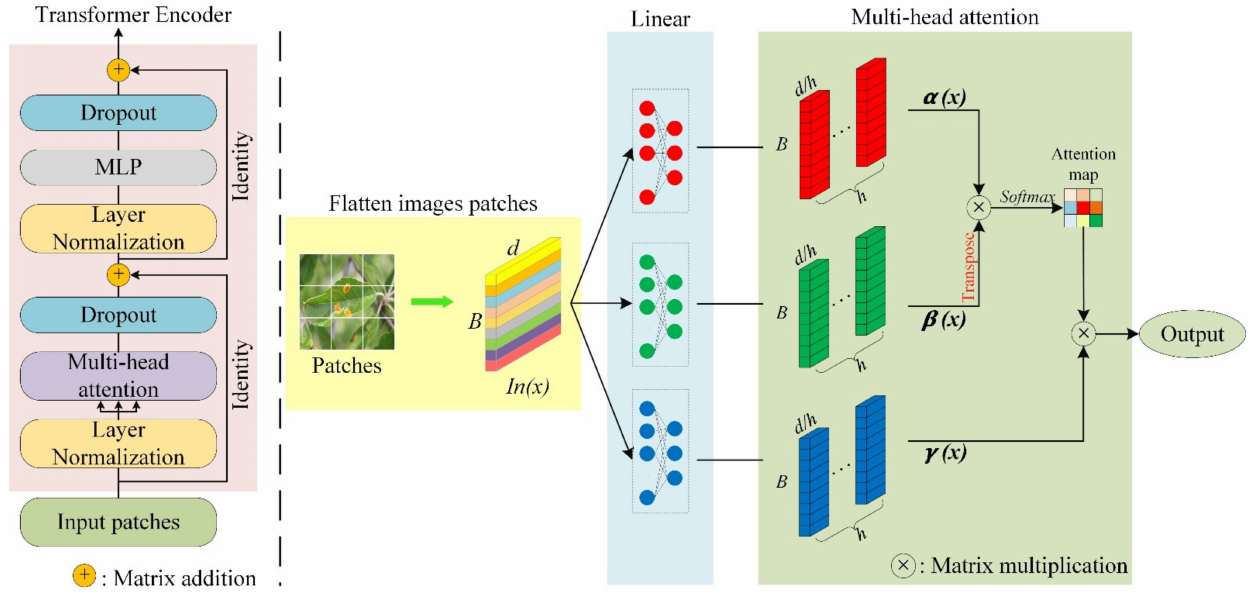
Figure 6. Structure of Transformer Encoder. The right side of the dashed line indicates that the linear transformation of In ( x ) is equally partitioned into h parts according to the number of groups. Attention map is obtained by matrix multiplication and Softmax , which is finally embedded in N( x ) to obtain the global